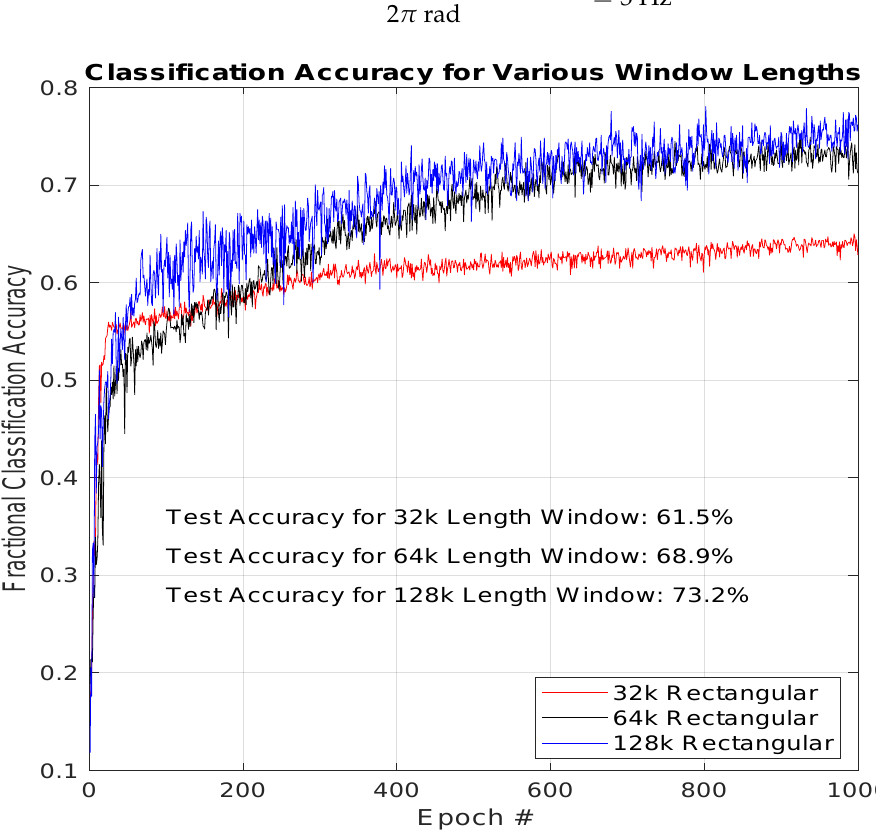
Figure 5. Classification accuracy vs. training epoch for various FFT window lengths with 15 × noise